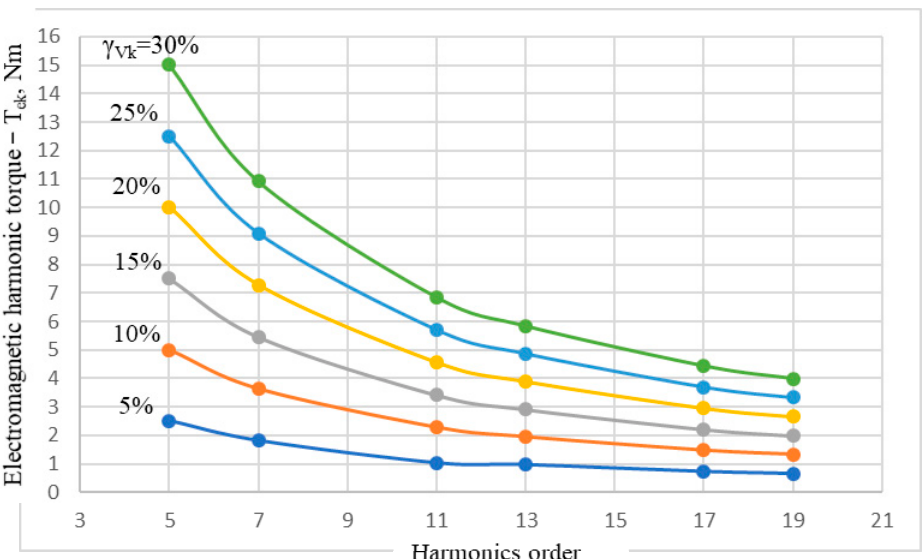
Figure 5. The amplitude of the electromagnetic harmonic torque of the IM in relation with the order and the level of the voltage harmonics.